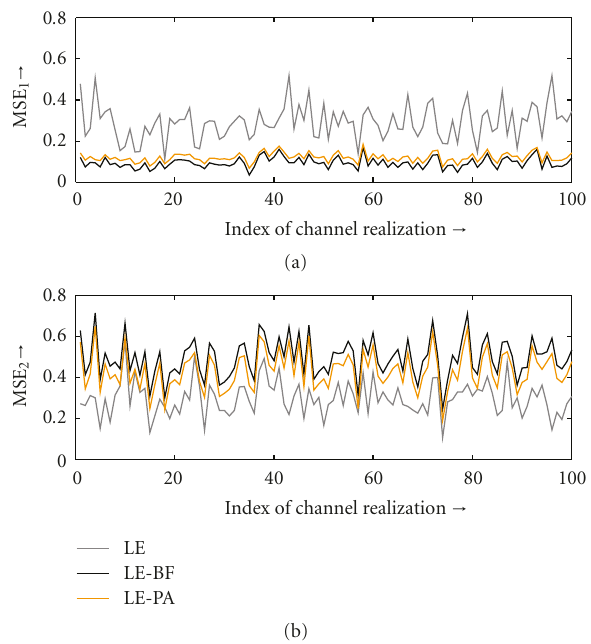
Figure 5: MSE at E b /N 0 = 7dB for LE, LE-PA, and LE-BF for transmit antenna 1 (a) and transmit antenna 2 (b), respectively, for di ff erent realizations of Pedestrian B channel impulse